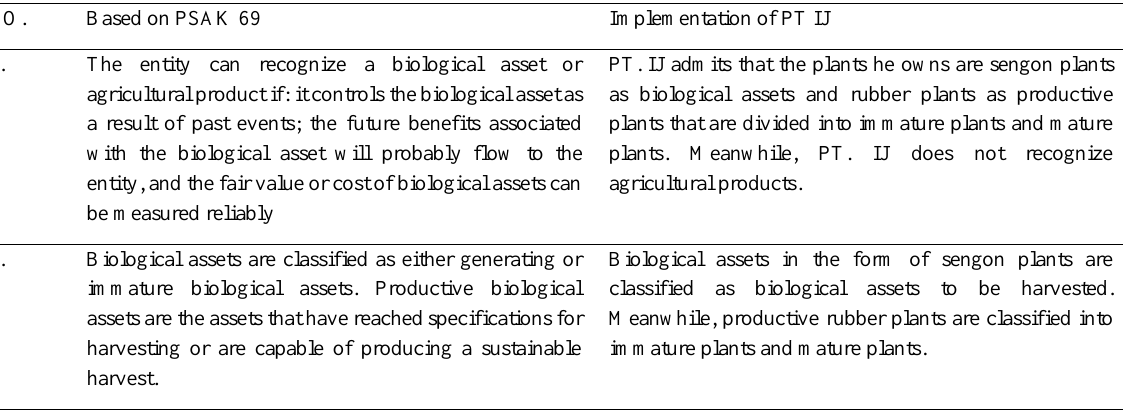
Table 3: Agricultural Activity Recognition Matrix